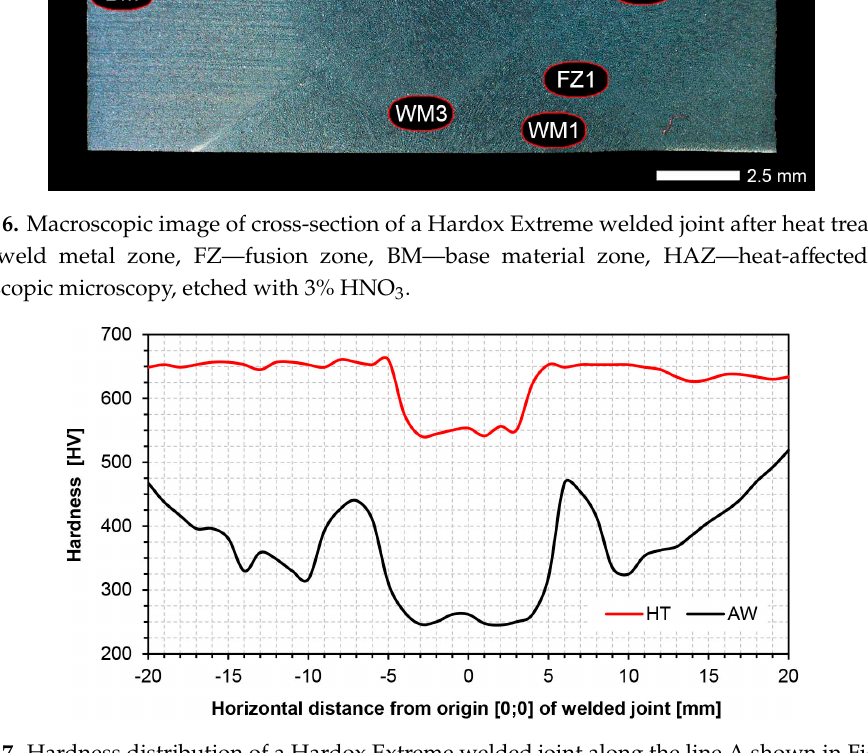
Figure 7. Hardness distribution of a Hardox Extreme welded joint along the line A shown in Figure 2. AW—condition after welding, HT—condition after heat treatment.